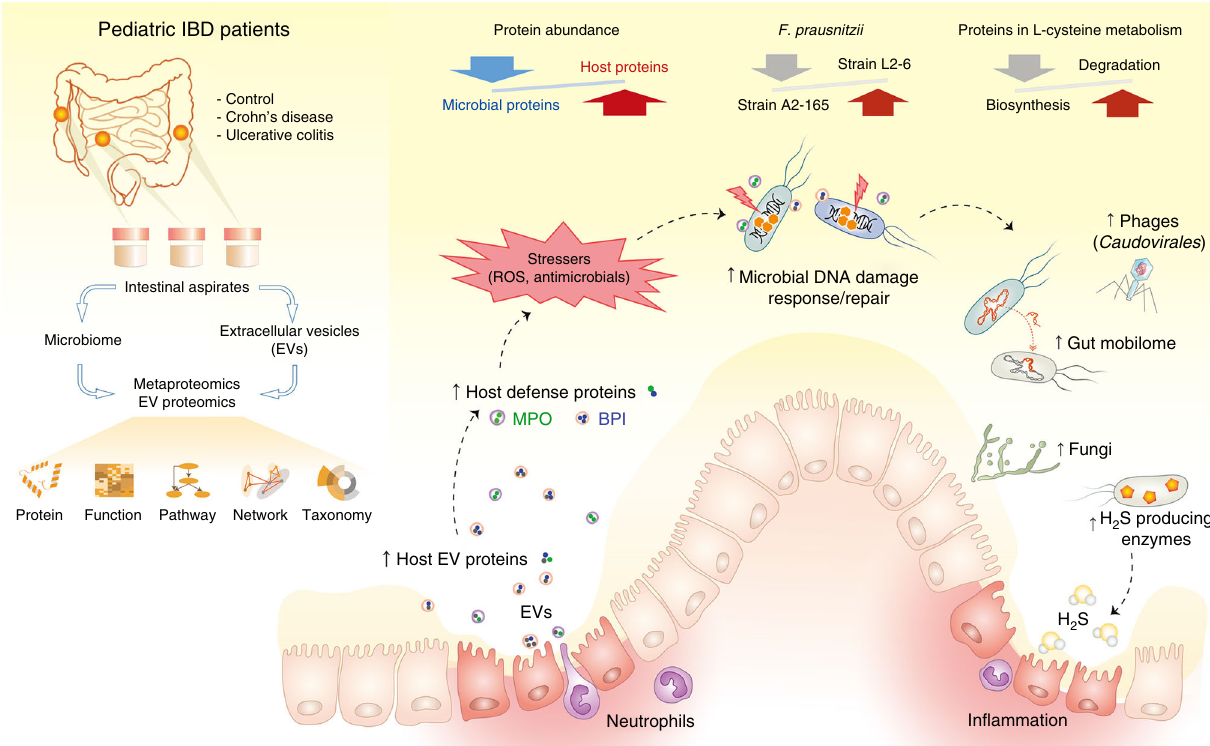
Fig. 7 Graphic summary of the study design and main fi ndings. Intestinal MLI aspirate samples were collected from three different intestinal regions from pediatric IBD patients or controls; the microbiomes and EVs were isolated and characterized using techniques including metaproteomics/proteomics approach. The differentially abundant human/microbial proteins, functions, pathways and microbial taxa were identi fi ed using multivariate statistical approaches. The intestinal MLI of IBD patients features an increased relative abundance of human proteins, in particular those EV-associated defense proteins, such as MPO and BPI, and a concomitant microbial dysbiosis at both functional and taxonomic